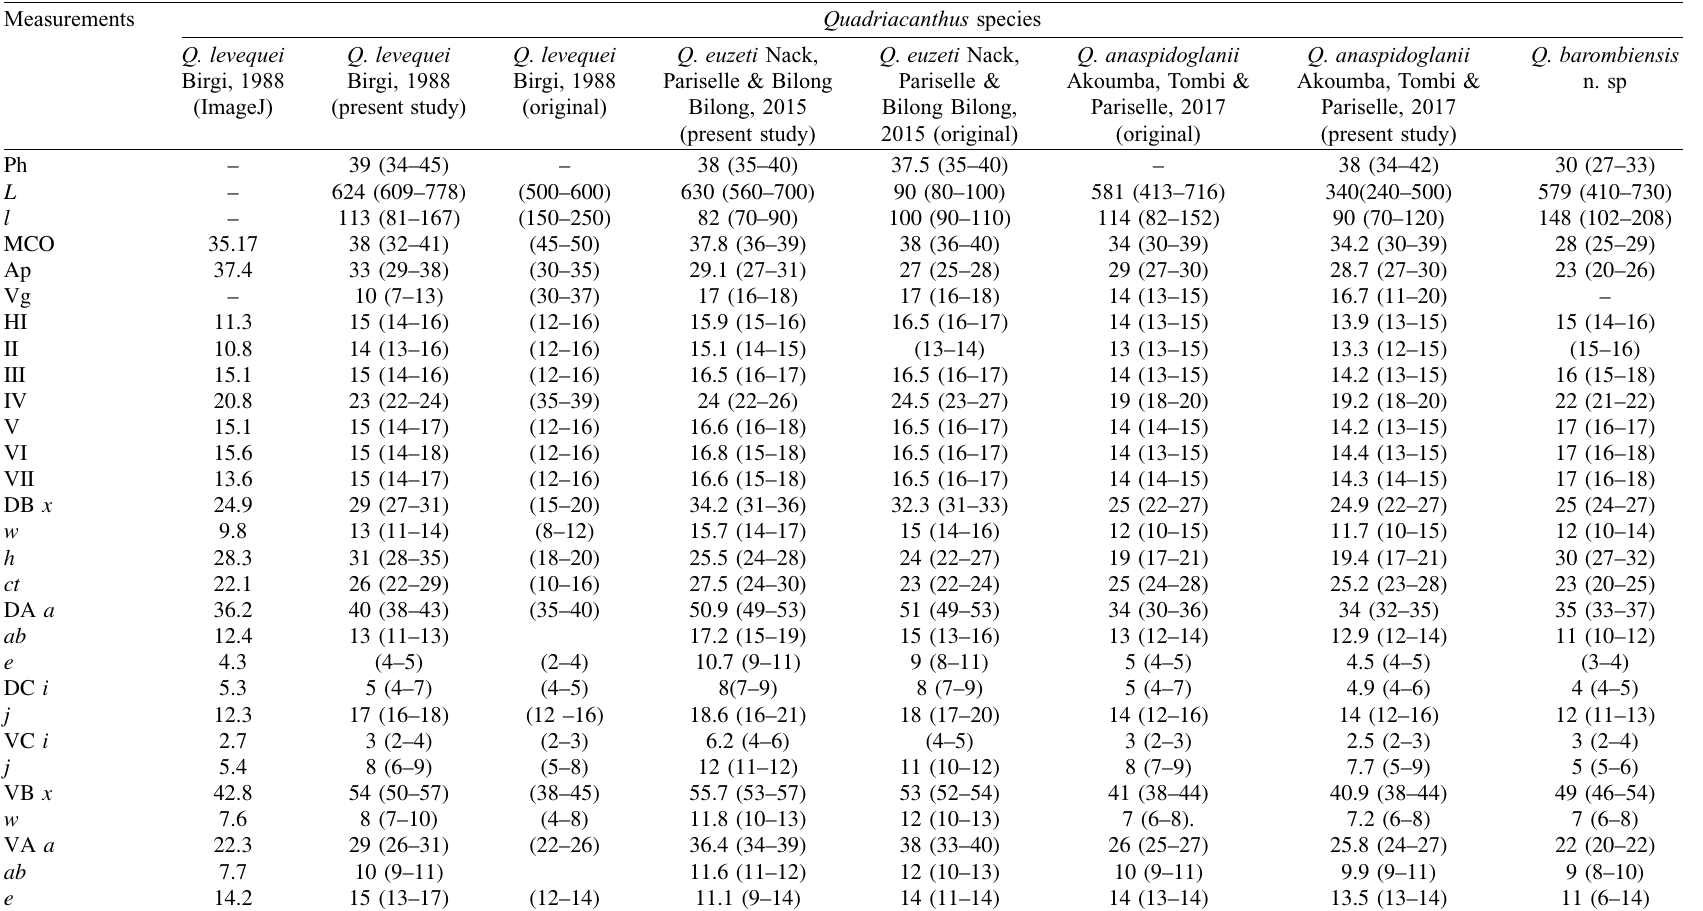
Table 1. Measurements of the four Quadriacanthus